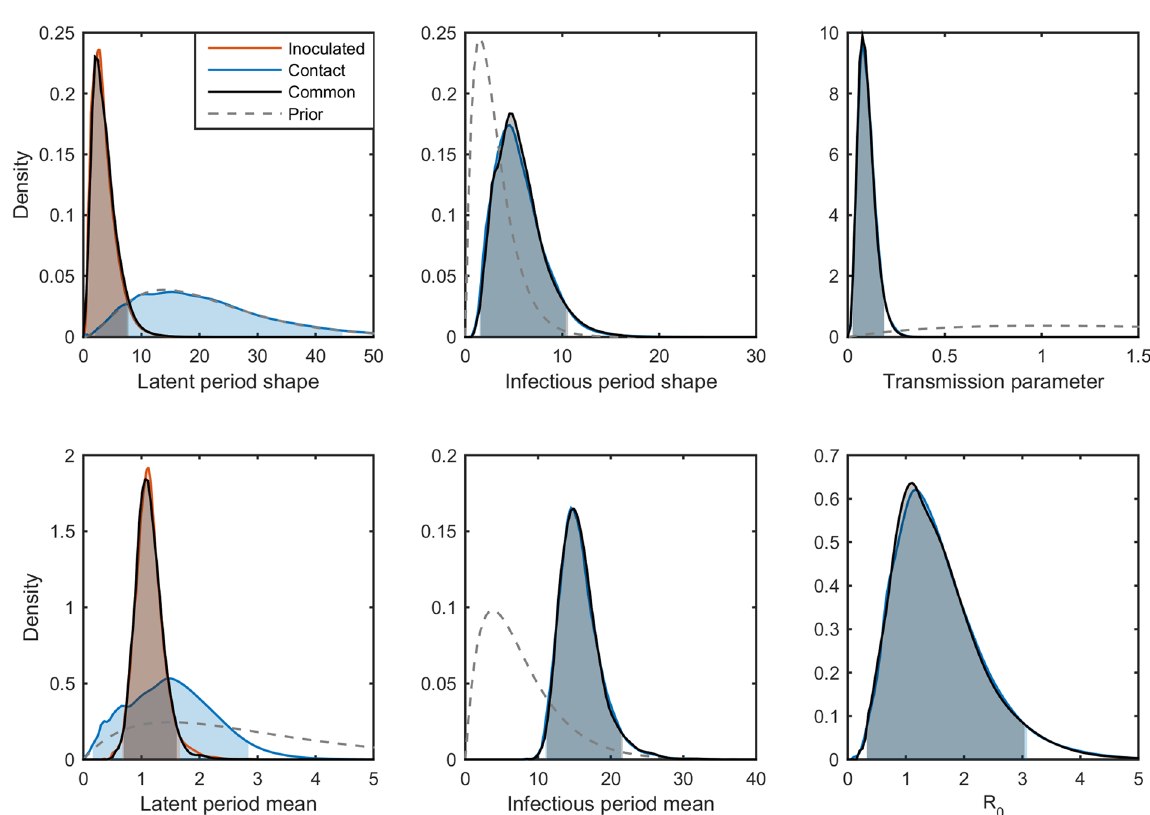
Figure 2. Epidemiological parameters for foot-and-mouth disease virus (FMDV) in lambs. Marginal posterior distributions for each parameter inferred from the FMDV transmission experiments between lambs. The latent period shape and mean posteriors are plotted in blue for in-contact lambs and in orange for inoculated. The model with a combined latent period distribution is plotted in grey. The shaded areas indicate the 95% highest posterior density intervals and priors are plotted as grey dashed